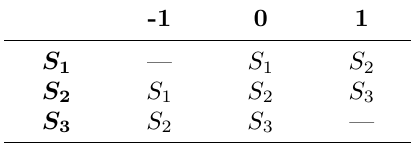
Table 1: Example state-transition